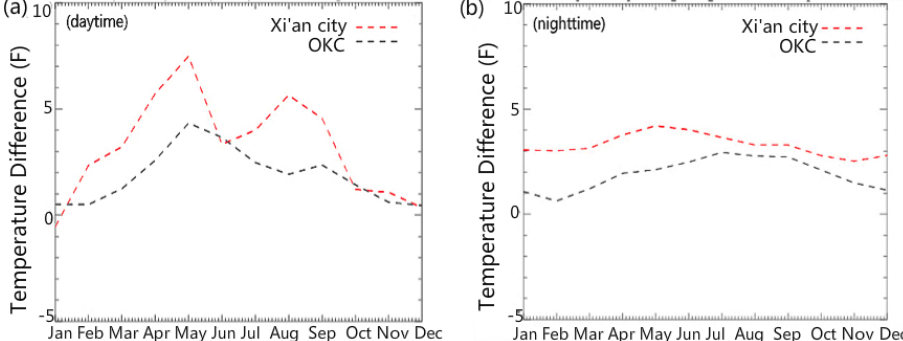
Figure 6. ( a ) Xi’an City and OKC monthly averaged daytime skin temperature difference (urban– nonurban); ( b ) Xi’an City and OKC monthly averaged nighttime skin temperature difference (urban– nonurban). Temperature unit in °F.